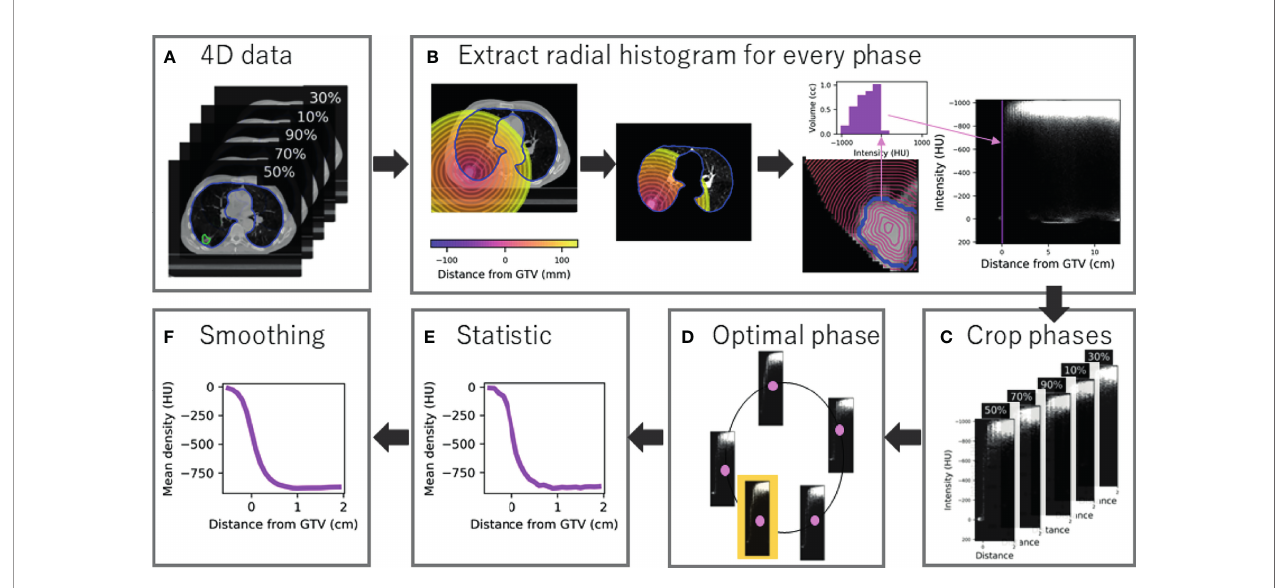
FIGURE 1 | Radial histogram methodology for 4D-CT data. (A) A GTV and lung contour is available and optimised to each phase of the 4D-CT data ( fi ve phases for example). (B) A radial histogram is extracted from every phase. First a signed distance transform map is created, which is cropped to lung tissue only, and fi nally an intensity histogram is extracted for every 1-mm annulus and mapped onto a 2D cross histogram. (C) Radial histograms for every phase are cropped to sample tumour and peritumour only. (D) The optimal phase histogram is selected by maximising the structural similarity matrix between neighbour phases. (E) Summary statistics are extracted at every mm with mean density shown for example. (F) Gaussian smoothing is applied to the curve to limit the in fl uence of